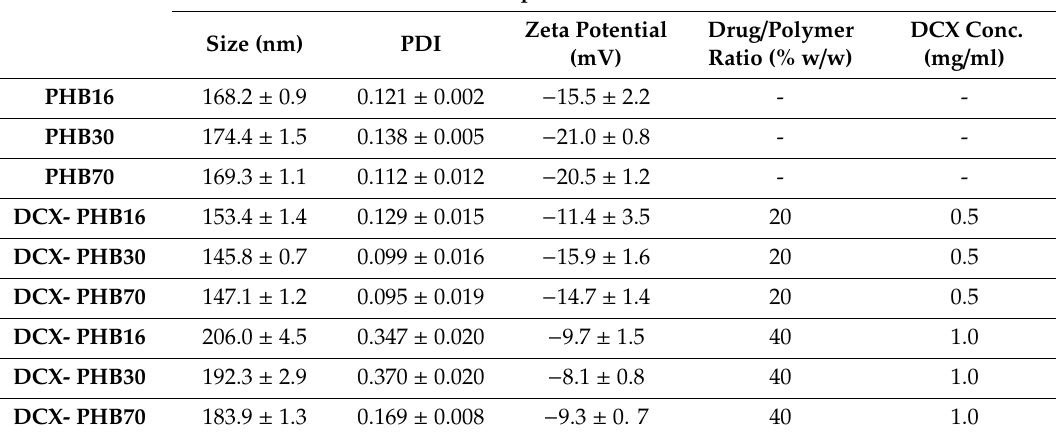
Table 1. Characteristics of blank and docetaxel (DCX)-loaded P(3HB- co -4HB) nanoparticles prepared by O / W emulsion solvent evaporation method using copolymers with di ff erent 4HB monomer content (mean ± SD, n =